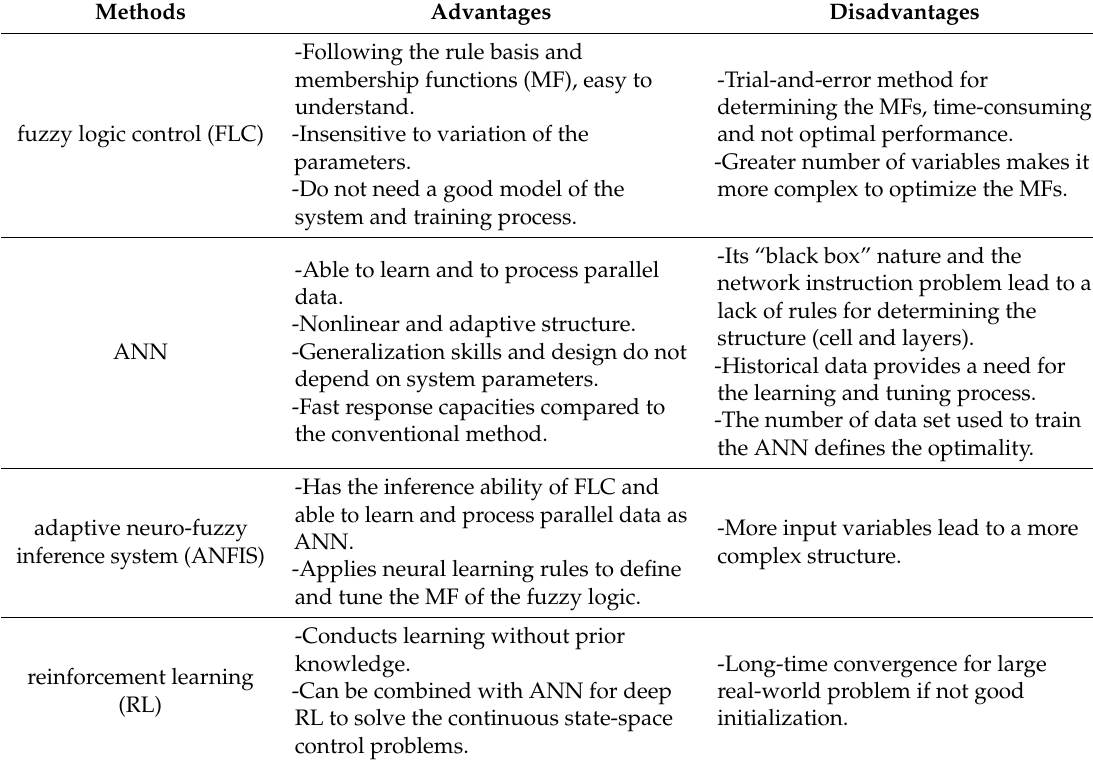
Table 1. The advantages and disadvantages of some recently developed